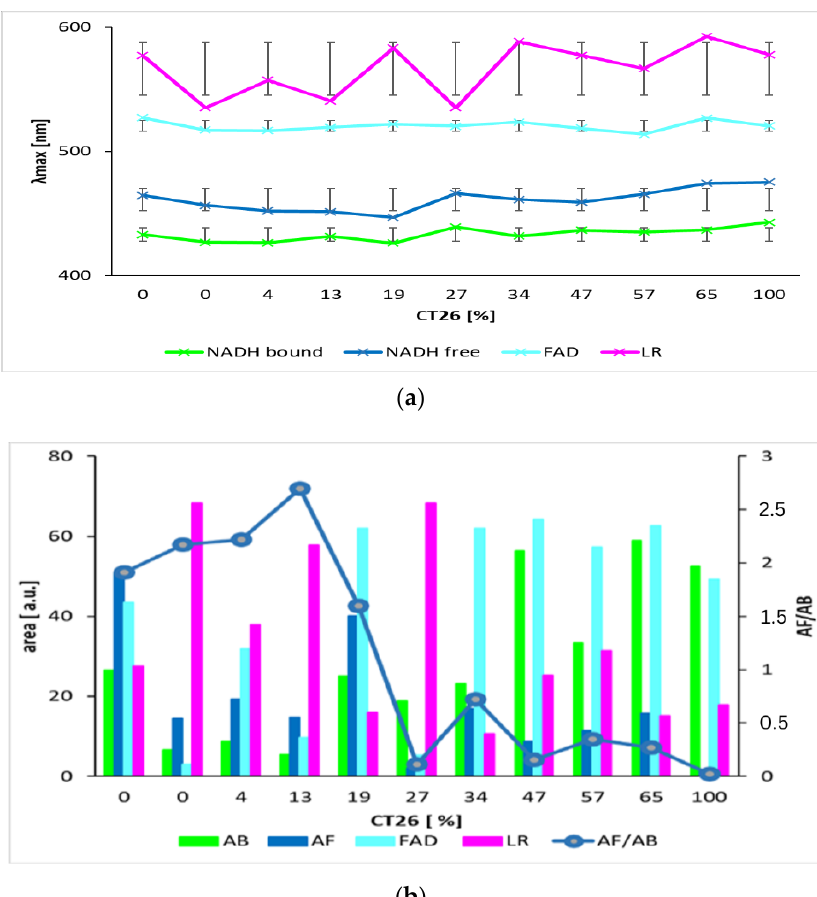
Figure 7. Parameters of calculated curves of deconvoluted spectra of mixtures of living healthy 3T3 and cancer CT26 cells. ( a ) wavelengths of maxima of calculated Gauss curves (line segments are mean squared deviations σ ). ( b ) areas under Gauss curves and ratio of bound and free NADH, AF/AB. (The graph shows results of two independent